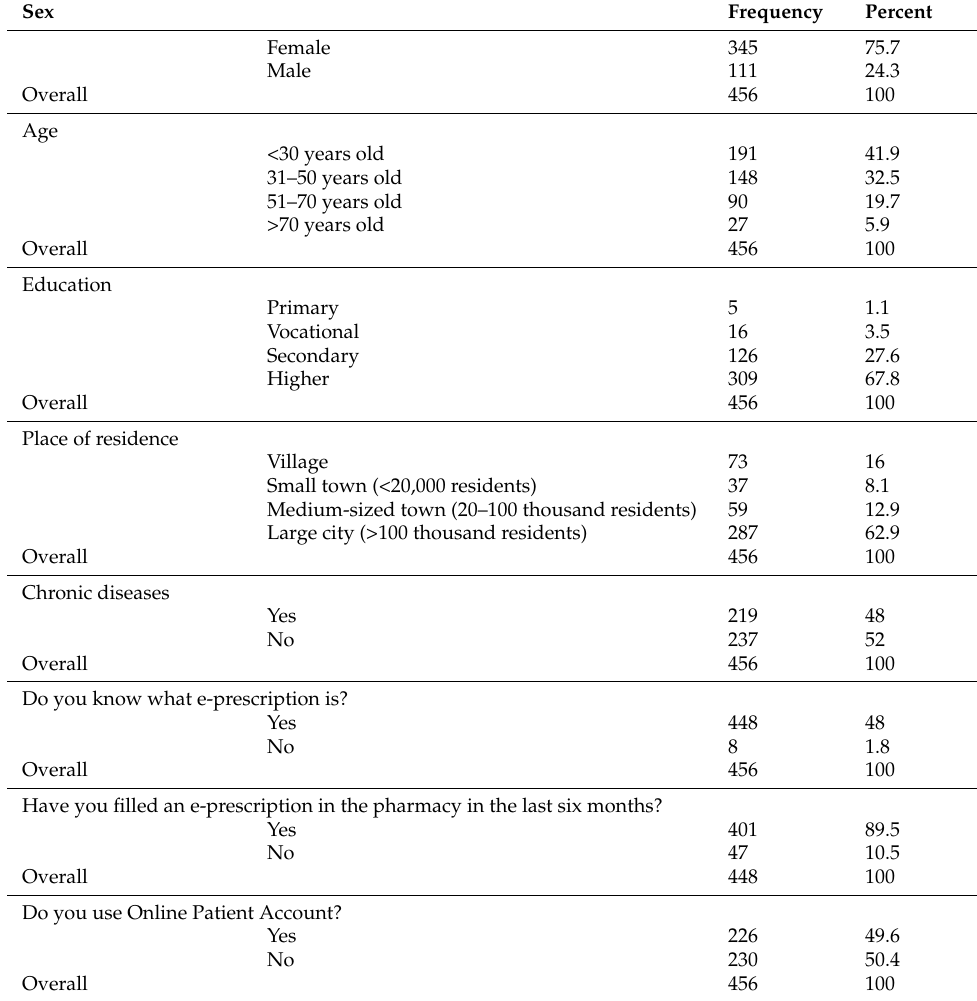
Table 1. Table presenting the characteristics of the study